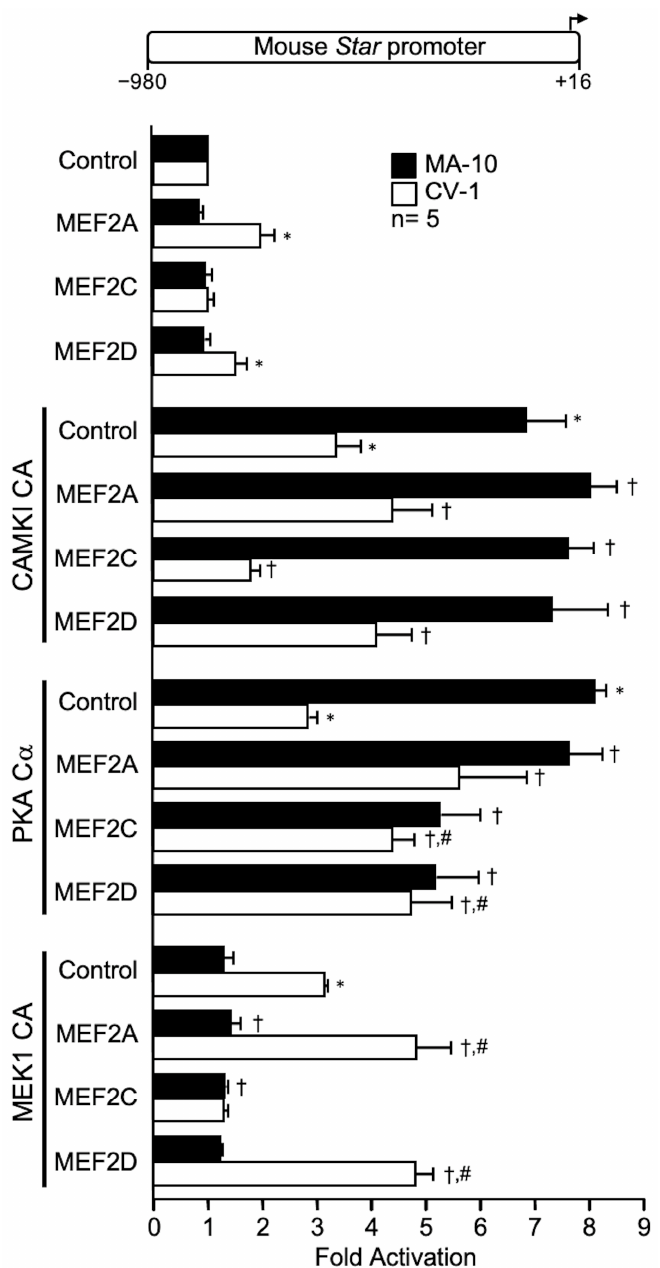
Figure 3. Cooperation between members of MADS box family of transcription factors and the kinases PKA catalytic subunit alpha (PKA C α ) and MEK1 constitutively active (MEK1 CA activates ERK1/2) on the mouse Star promoter. MA-10 Leydig (black bars) and CV-1 fibroblast (white bars) cells were cotransfected with an empty expression vector as a control or expression vectors for various MADS box family members (MEF2A, MEF2C, MEF2D) and kinases (CAMKI CA, PKA C α , MEK1 CA) individually or in combination as indicated, along with a − 980 to +16 bp mouse Star reporter. Results are shown as Fold Activation over control ± SEM. An asterisk (*) represents a statistically significant difference in activation by the transcription factor or the kinase compared to control (empty expression vector, value set at 1, p < 0.05). A dagger (†) represents a statistically significant difference in activation between the transcription factor + the kinase compared to the corresponding transcription factor alone ( p < 0.05). A hashtag (#) represents a statistically significant difference in activation between the transcription factor + the kinase compared to the kinase alone ( p < 0.05). The number (n) of replicates is indicated.